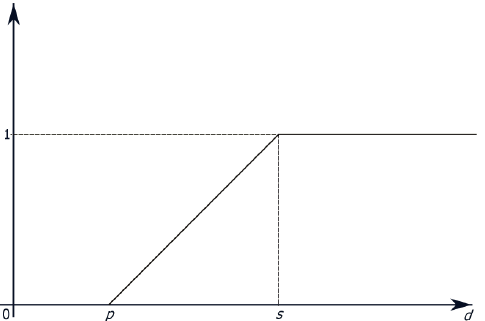
Figure 1. The criterion preference function. Here, p and s values define the threshold at which criteria values are taken into consideration.